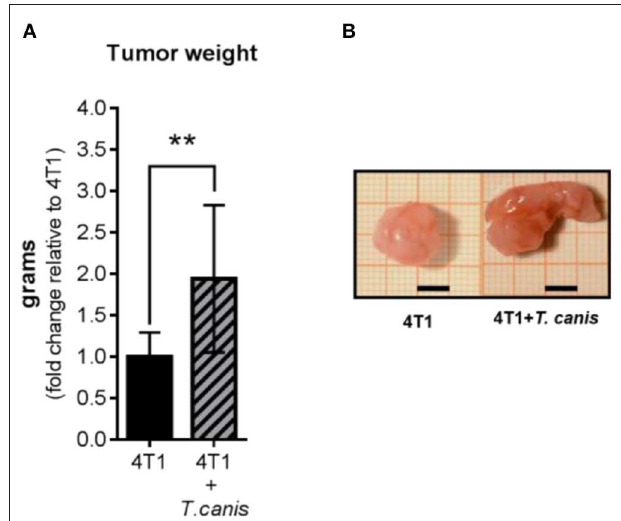
FIGURE 1 | Tumor growth. (A) Tumor weight from control (4T1) and infected animals (4T1- T. canis ). (B) Representative images of tumors from both groups (4T1 and 4T1 + T. canis ). Millimetric grid as a background; black bar = 0.5cm. Graphs represent the mean ± SD of the data from two experiments (4T1, n